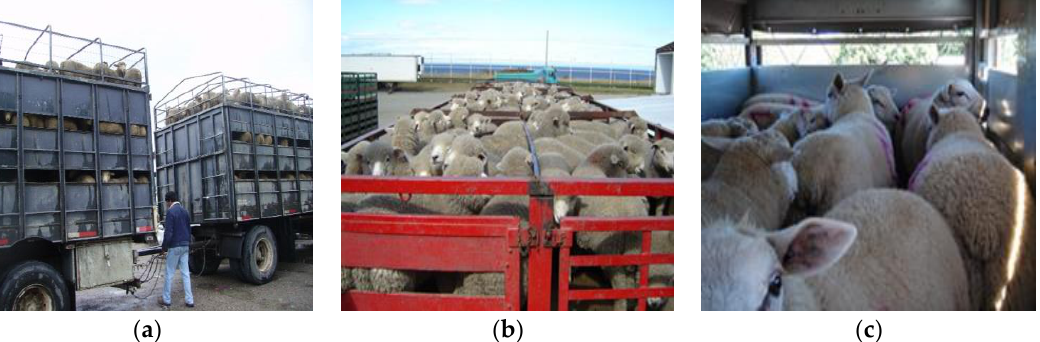
Figure 7. ( a , b ) Vehicles loaded with lambs at space allowances of approximately 0.66 m 2 /100 kg; ( c ) small trailer carrying lambs produced by small farmers at approximately 0.8 m 2 /100